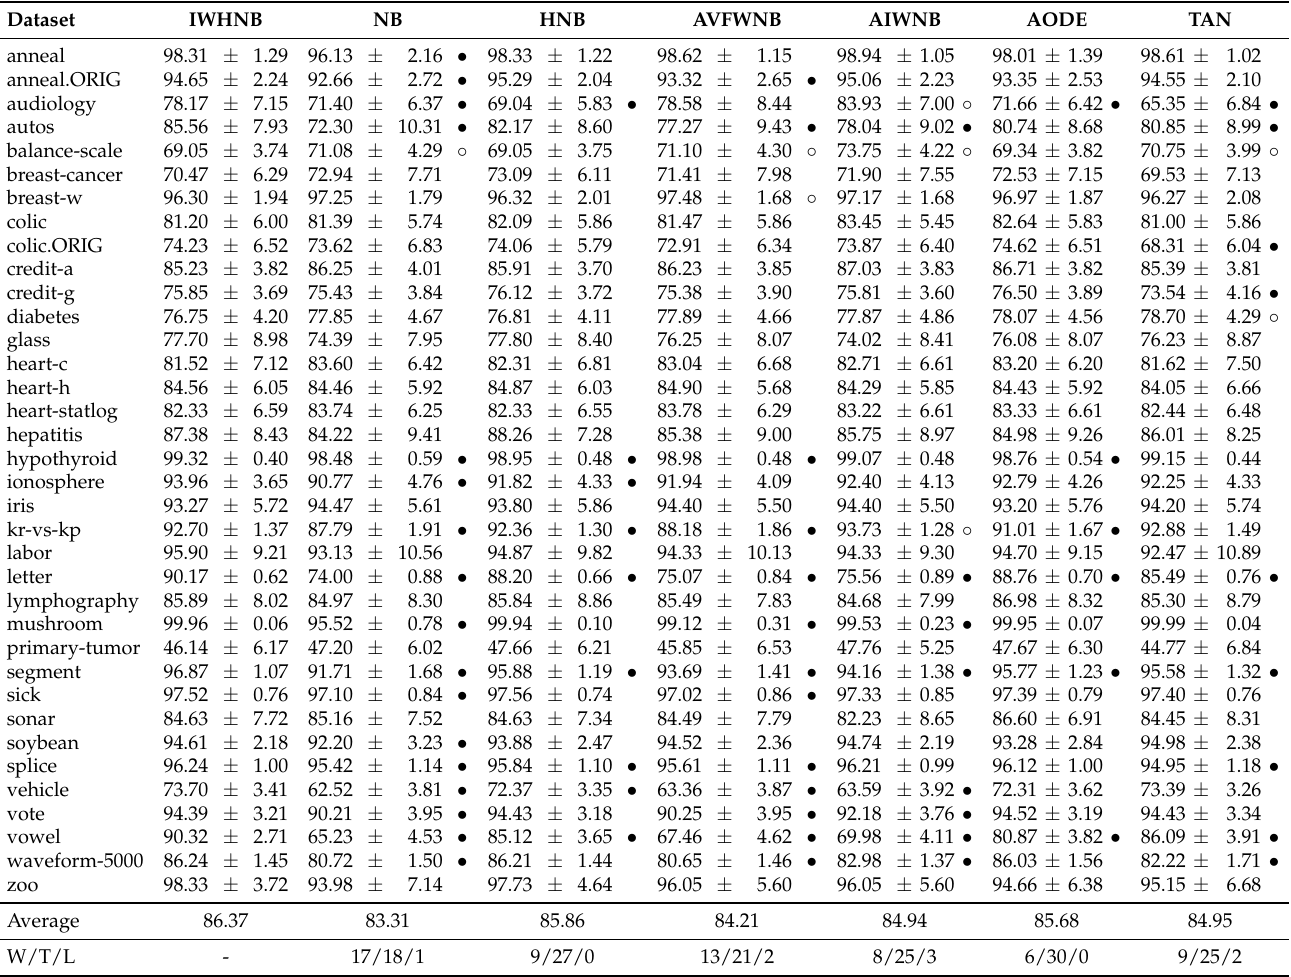
Table 1. Comparisons of the classification accuracy for IWHNB versus NB, HNB, AVFWNB, AIWNB, AODE and TAN.